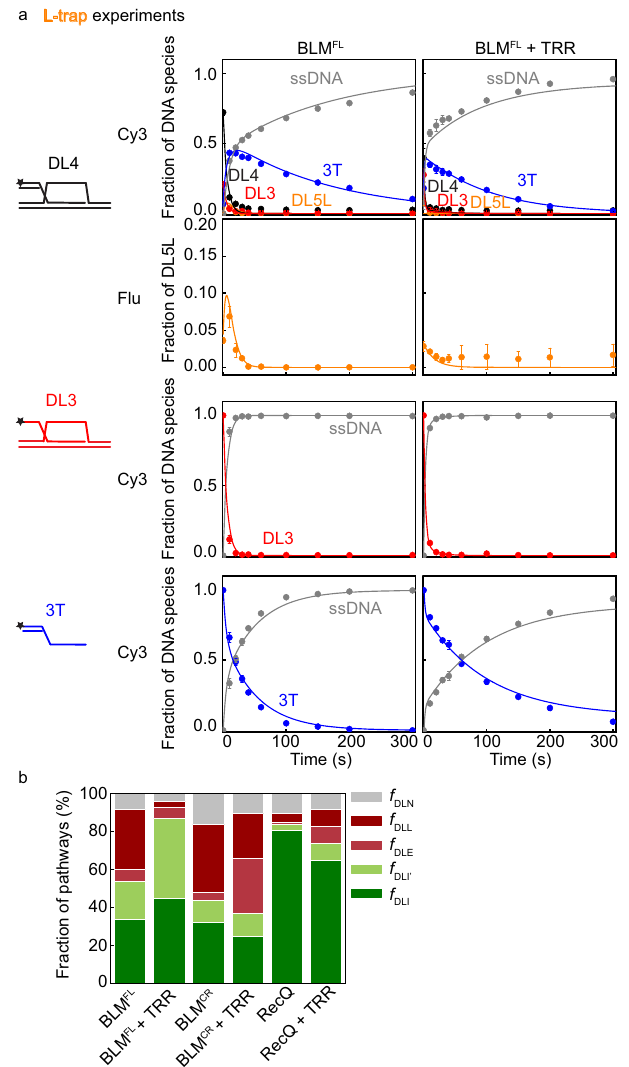
Fig. 8 Effect of TRR on the D-loop processing activities of BLM and RecQ constructs. a Kinetic pro fi les of DL4, DL3, and 3T unwinding by BLM FL in the absence and presence of 1.2 µ M TRR. Additional kinetic pro fi les for other protein constructs are shown in Supplementary Fig. 13. Solid lines show global best- fi ts of the model described in Supplementary Fig. 7 to all unwinding data (DL4, DL3, and 3T) of BLM FL with and without TRR. Means ± SEM are shown on all panels for the detected fractions of DNA species at each time point determined from independent experiments ( n = 3 for DL4 experiments, n = 2 for 3T and DL3 experiments) with individual protein constructs. b Distributions of enzyme – DL (DL4 or DL3) con fi gurations resulting from global fi ts shown in panel a and Supplementary Fig 13. Con fi gurations leading to D-loop disruption are colored with green shades, whereas those leading to D-loop stabilization in an in vivo context are colored with shades of red. Determined parameters are listed in Supplementary Table 3. Source data are provided as a Source Data fi